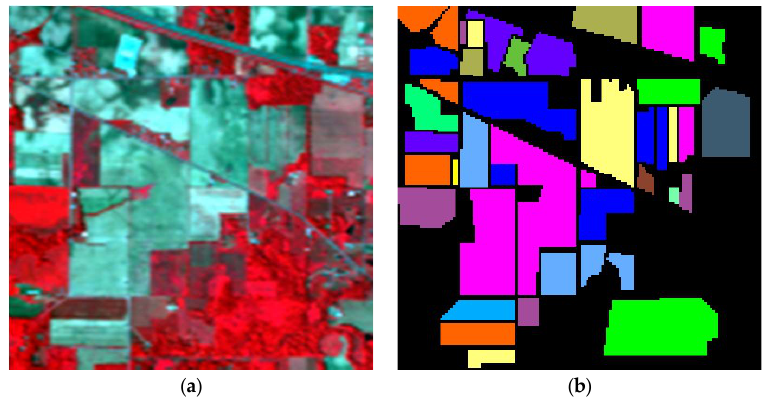
Figure 3. ( a ) false color map and ( b ) ground truth of the Indian Pines dataset.